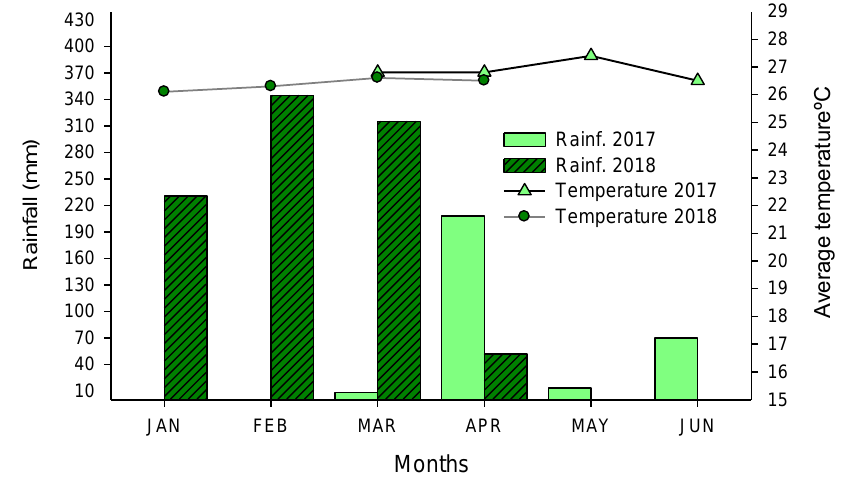
Figure 1. Average monthly rainfall and temperature for the experimental site during the 2016–2018 growing season.